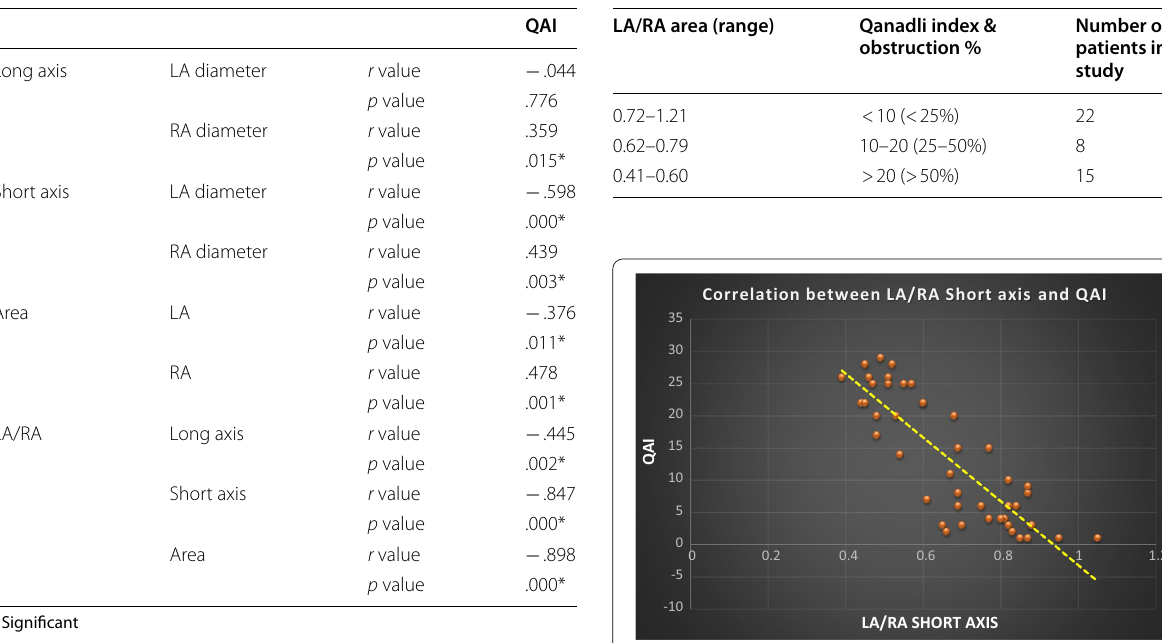
Table 3 Pearson’s correlation between QAI and long, short axis, area OF LA and RA